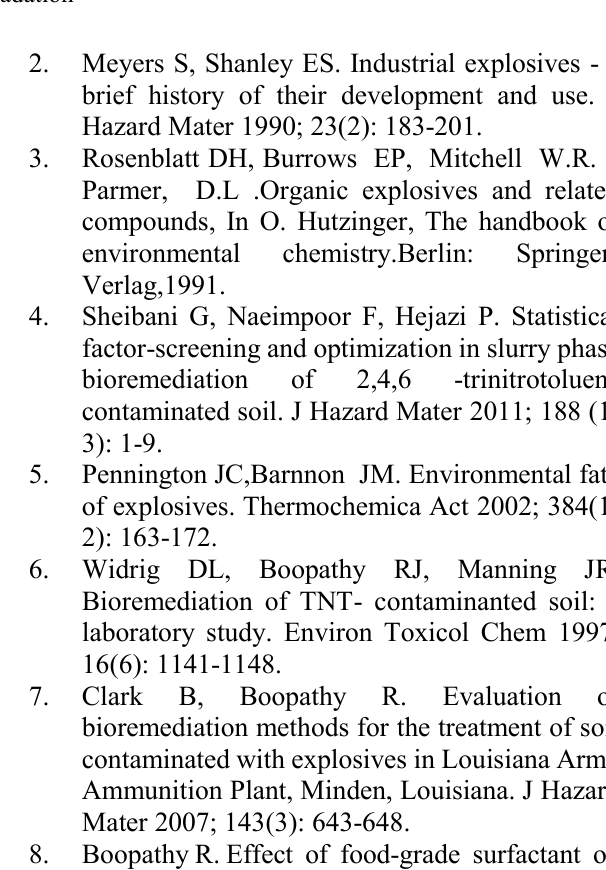
Fig. 5. Chromatogram analysis of the TNT